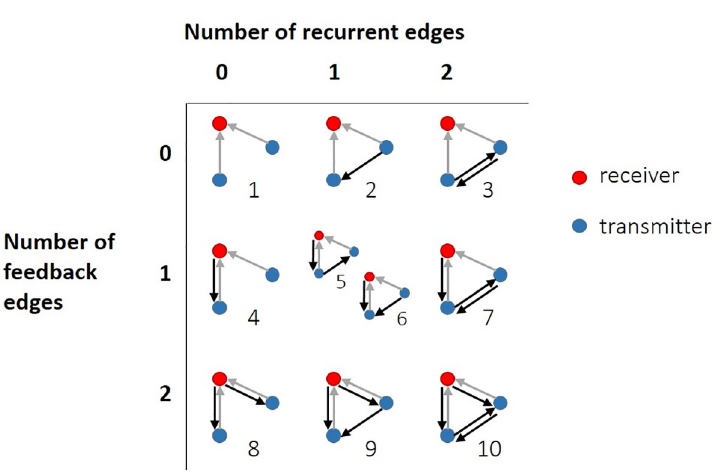
Fig 2. Set of synergistic 3-node motifs. Synergistic motifs were those in which both transmitters (blue dots) sent input (gray arrows) to the same receiver (red dots). Motifs were arranged in order (1–10) of the number of feedback and recurrent edges they contained (black arrows); either 0, 1 or 2.